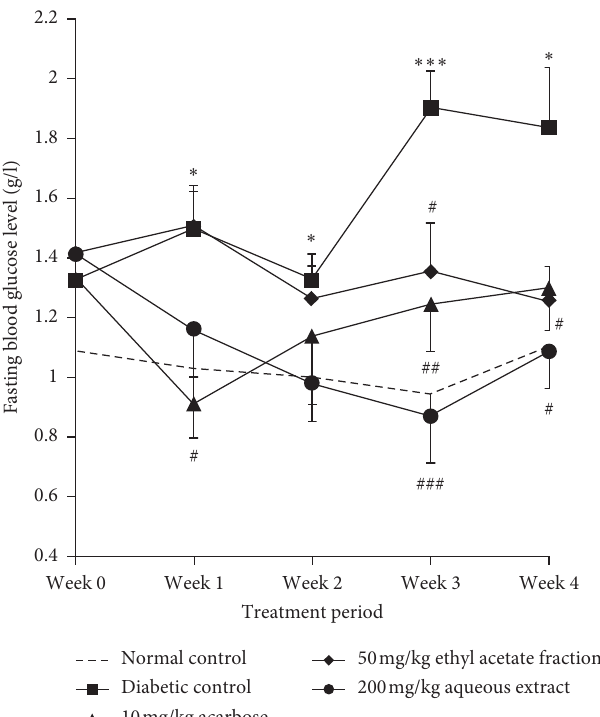
Figure 2: Effect of aqueous extract (AqTh), ethyl acetate fraction (EaTh) of T. hirsute , and acarbose on blood glucose level after sucrose loading in STZ-induced diabetic rats. Each value represents the means ± SEM. n � 5-6. ∗ p < 0 . 05 and ∗∗∗ p < 0 . 001 compared with the normal group at each point. # p < 0 . 05 and ## p < 0 . 01 compared with the diabetic group at each point. All statistical tests were used with one-tail p value.